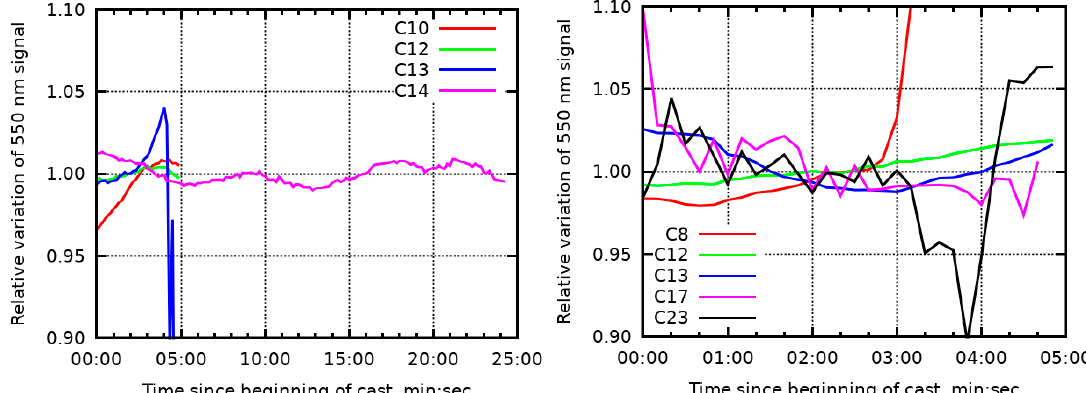
Figure 6. Relative variation of 550 nm signal of one RAMSES sensor during irradiance ( left ) and radiance ( right ; C8, C12 , C13 blue sky; C17 water in cloud shadow; C23 sunlit water) casts selected for intercomparison analysis.